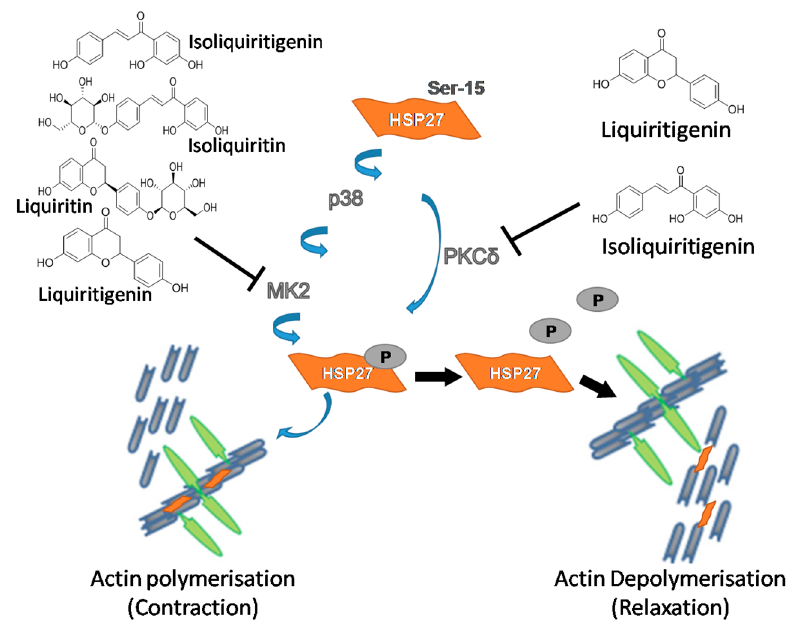
Figure 9. Schematic representation of a model for spasmolytic mechanism of bioactive constituents from aqueous licorice extract on uterine contraction through inhibiting the phosphorylation of heat shock protein 27.